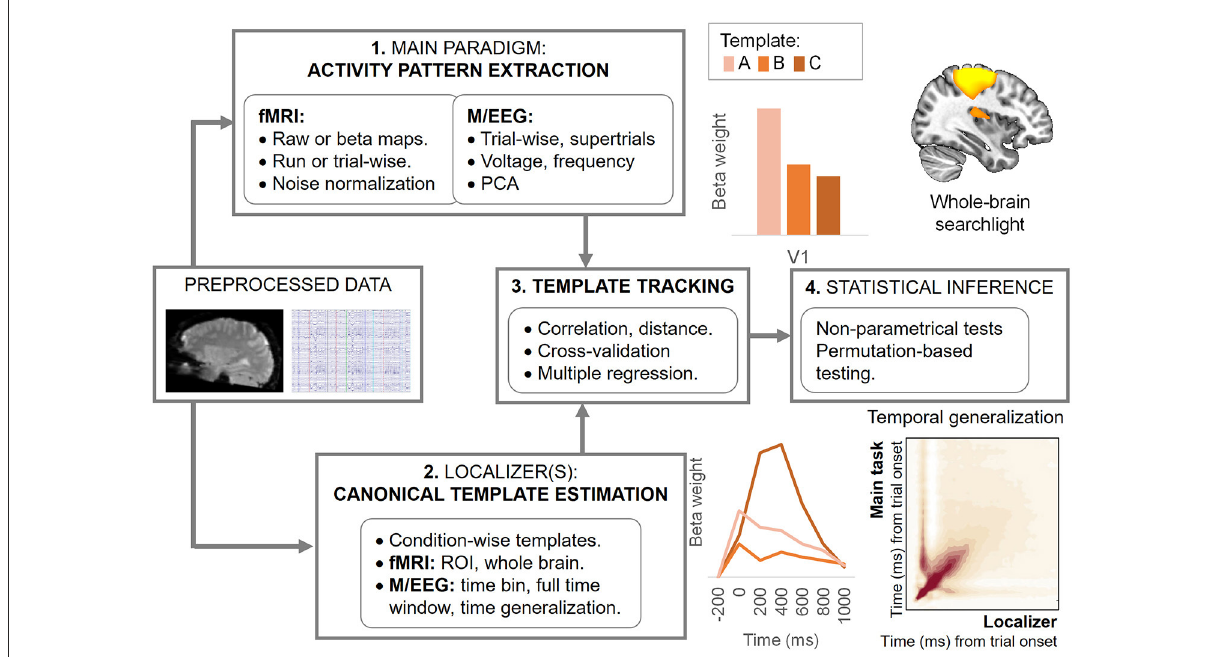
FIGURE2 Analysis steps during canonical template tracking. The figure synthesizes the analysis protocol, from the data preprocessing to statistical inference. Insets figures, at the right, show different predicted outputs that could be obtained with CTT when applied to spatially resolved (upper section) and temporally resolved (lower section) techniques. The upper section shows examples from ROI (left) and searchlight-based (right) analyses. The lower section shows examples of the time course of different templates activation indexes (left) and a temporal generalization matrix (right)